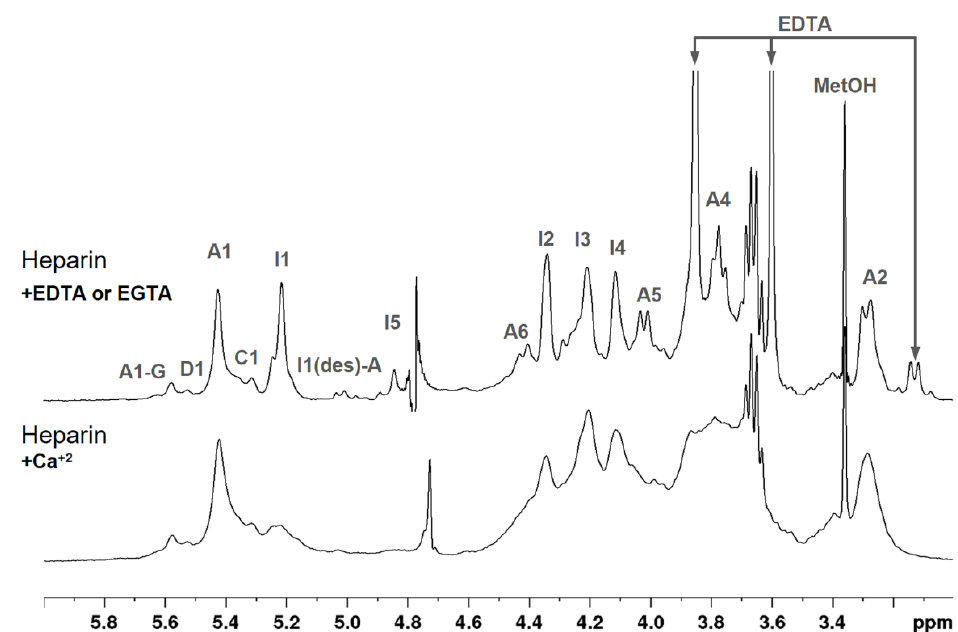
Figure 5. One-dimensional 1H NMR spectra (3.0 → 6.0 ppm) of a pharmaceutical heparin batch containing calcium, before and after the addition of EDTA. Signals attributed to EDTA are indicated with arrows. Note the absence of the I1 signal in the spectrum of heparin containing calcium, which in turn becomes well-defined signals after addition of calcium-chelators in the sample.